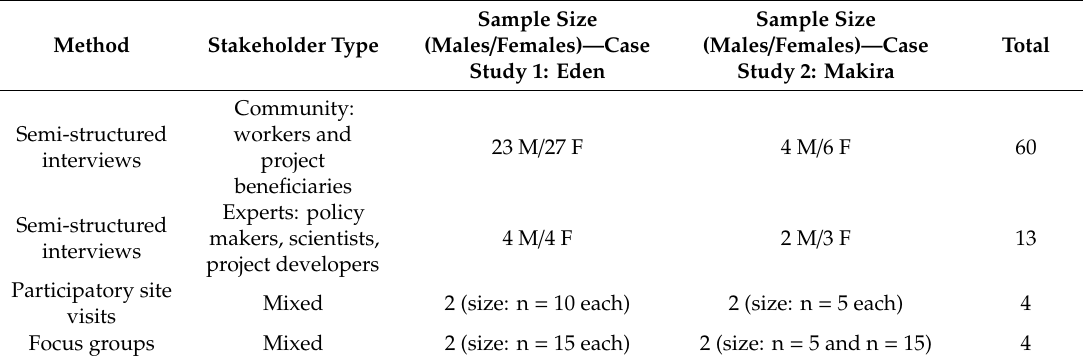
Table 1. Summary and sample size of multi-level and mixed-method research approaches used across case